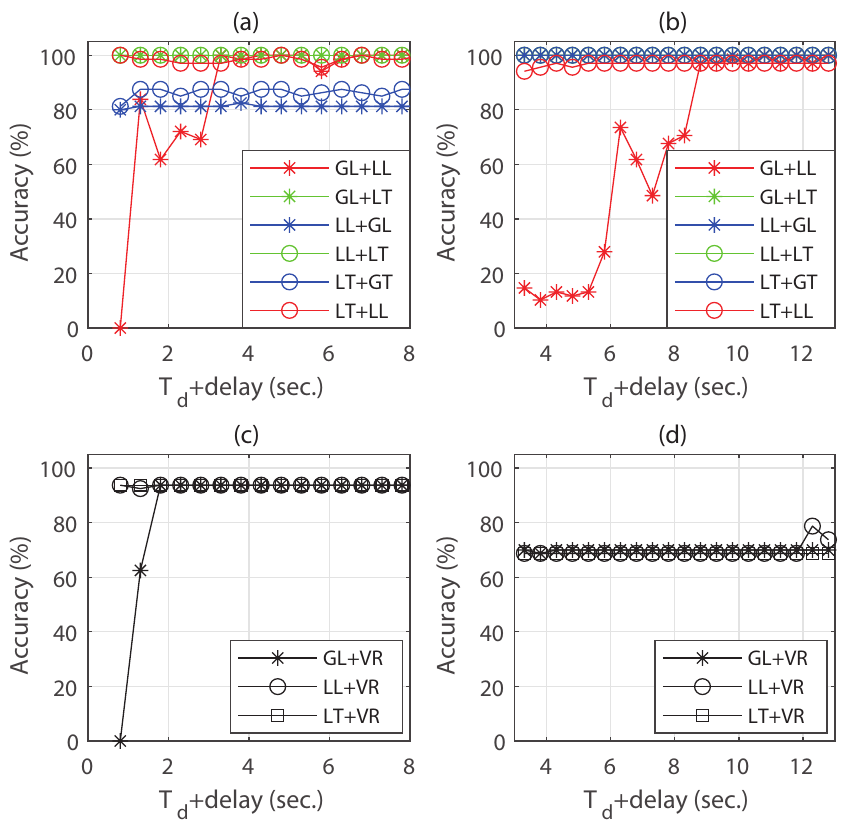
Figure 8. Performance of successive event type identification at 3 first event types and 4 follow- ing event types with windowing delay (C1: 0.3 s, C2: 2.9 s): ( a , c ) are C1 classification, ( b , d ) are C2 classification.